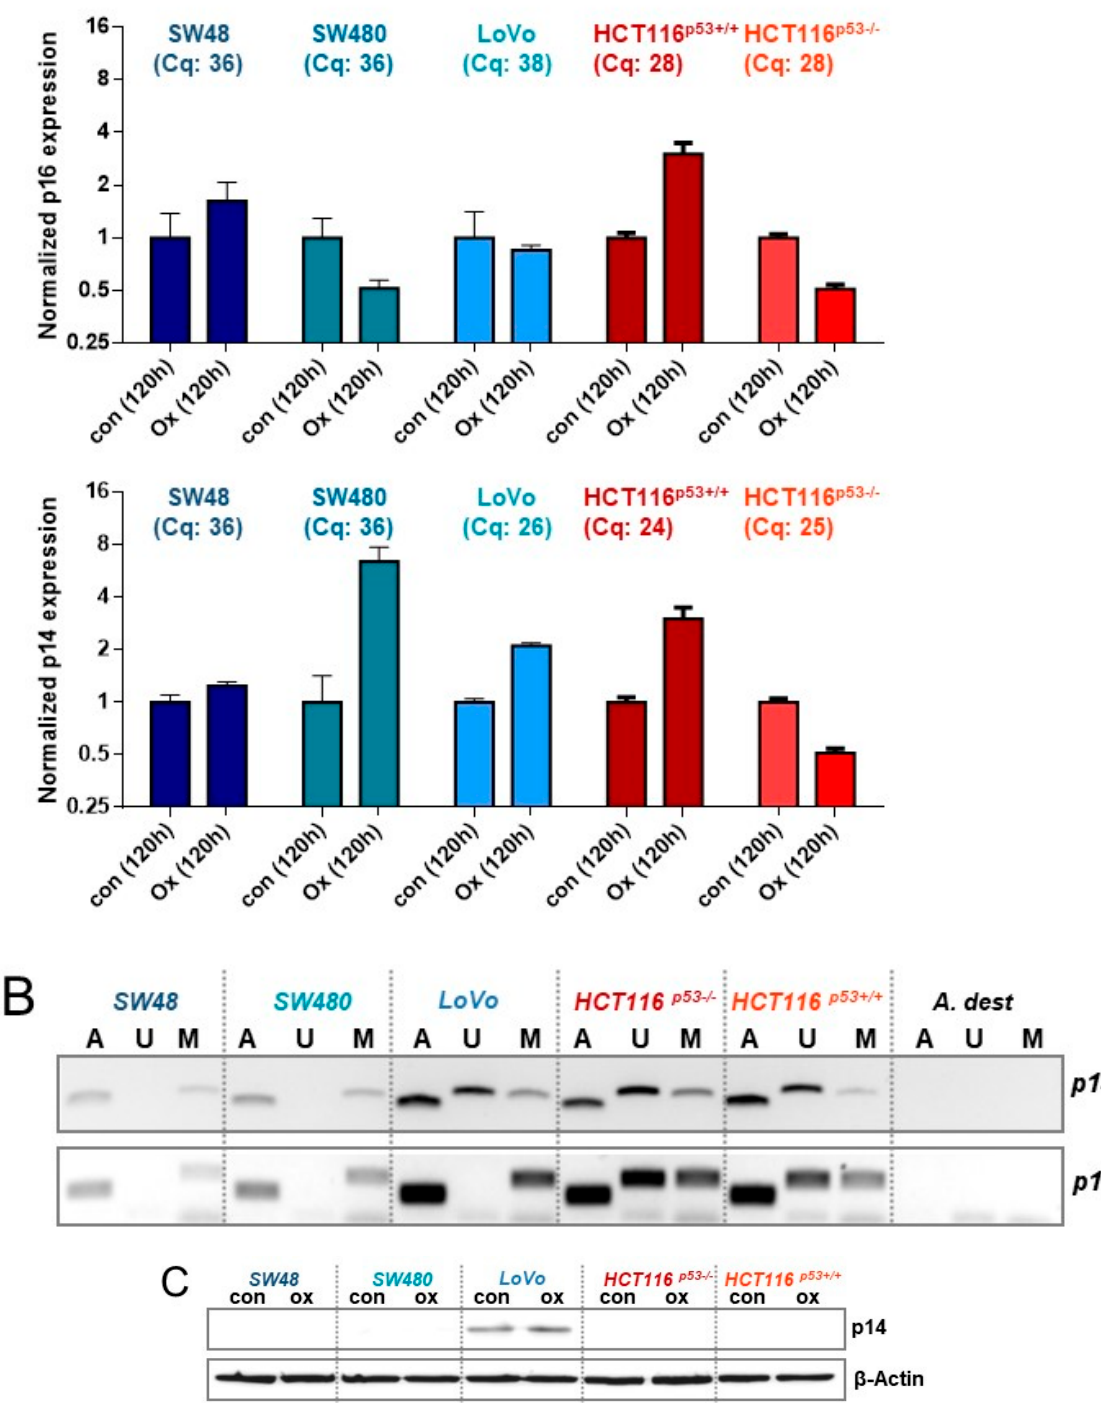
Figure 6. ( A ) CRC cells were treated with 2.5 µM oxaliplatin; 120 h later, the expression of p14 ARF and p16 INK4a mRNA was measured by qPCR. Cq values of the 120 h-control are provided for all cell lines. ( B ) Genomic DNA obtained from CRC cells was modified by bisulfite conversion and the 5meC methylation of p14 ARF and p16 INK4a was measured by methylation-specific PCR (MSP). U = unmethylated, M = methylated, A = ACTB (positive control). ( C ) CRC cells were treated with 2.5 µM oxaliplatin. 120 h later, the expression of p14 ARF was determined by western-blot analysis. β -Actin was used as internal loading control.